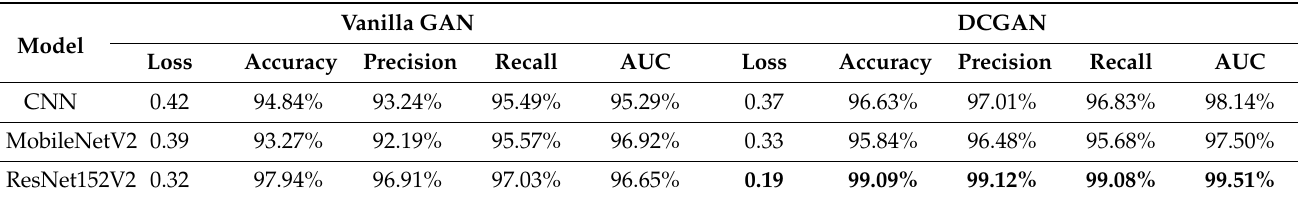
Table 7. Evaluation metrics for the different models using Vanilla GAN and DCGAN image generated.